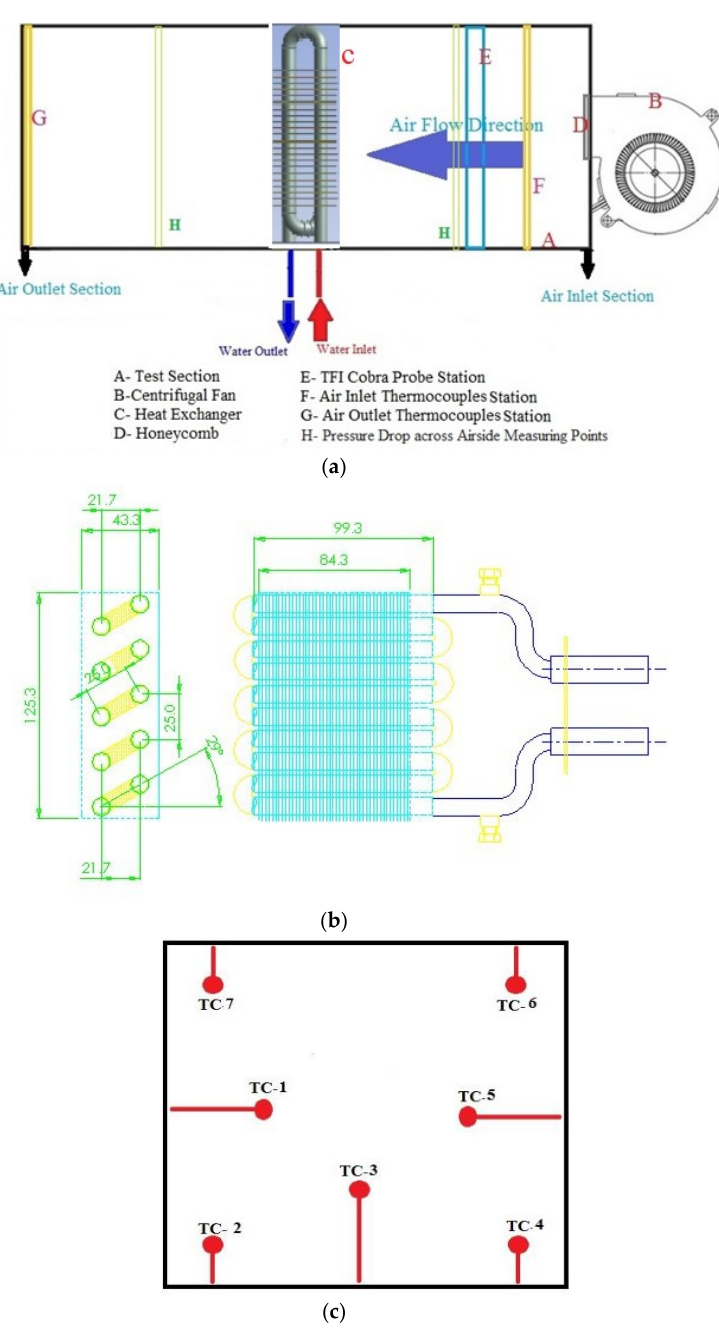
Figure 2. ( a ) Schematic representation of the heat exchanger testing unit ( b ) dimensions of the plain fin heat exchanger ( c ) Arrangement of thermocouples at the specific measurement location. The heat exchanger’s airside pressure drop was measured using a DPM TT550 micro- manometer. It has the ability of measuring the static pressure within the range: 0.4–5000 Pa. The heat exchanger’s water side pressure drop was measured using two pressure transducers. They were respectively placed at the water inlet and outlet tubes and were